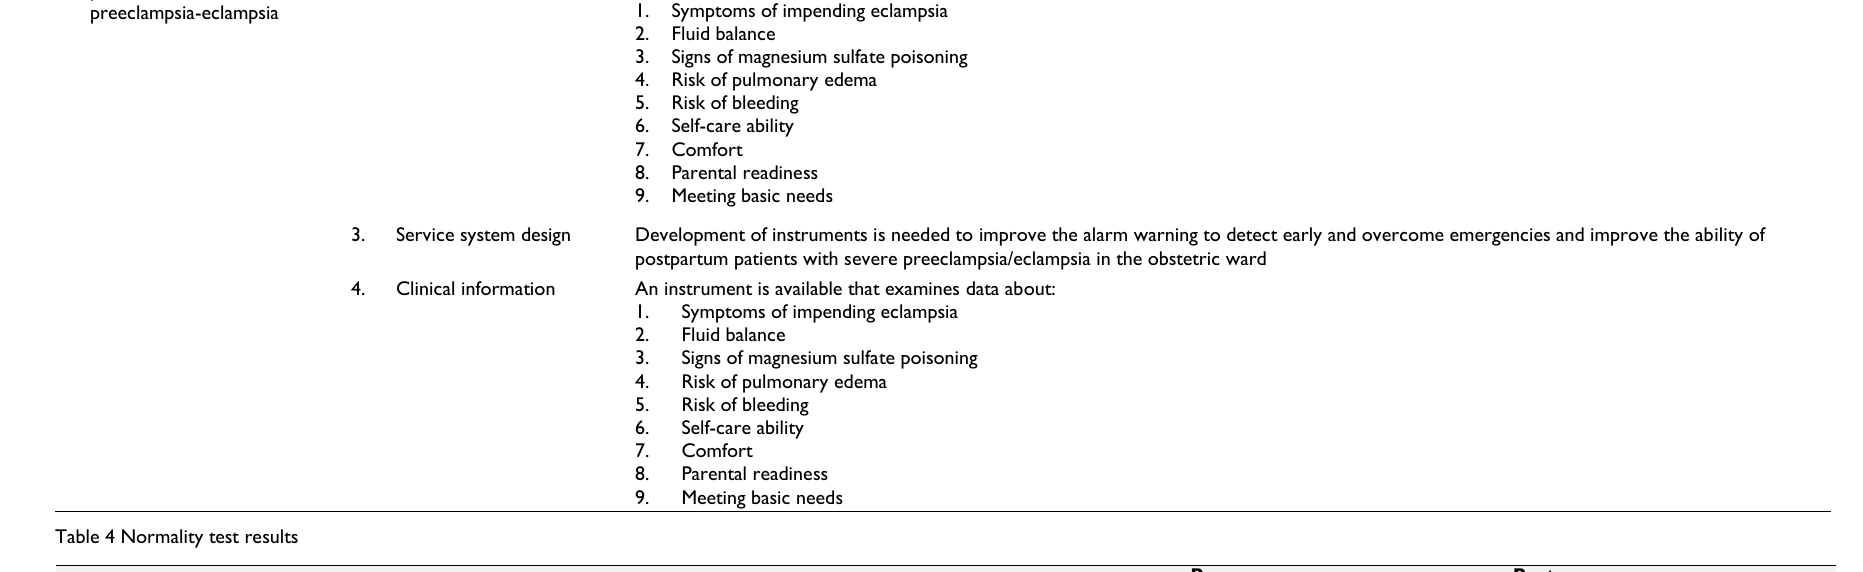
Table 5 Statistical test results Group